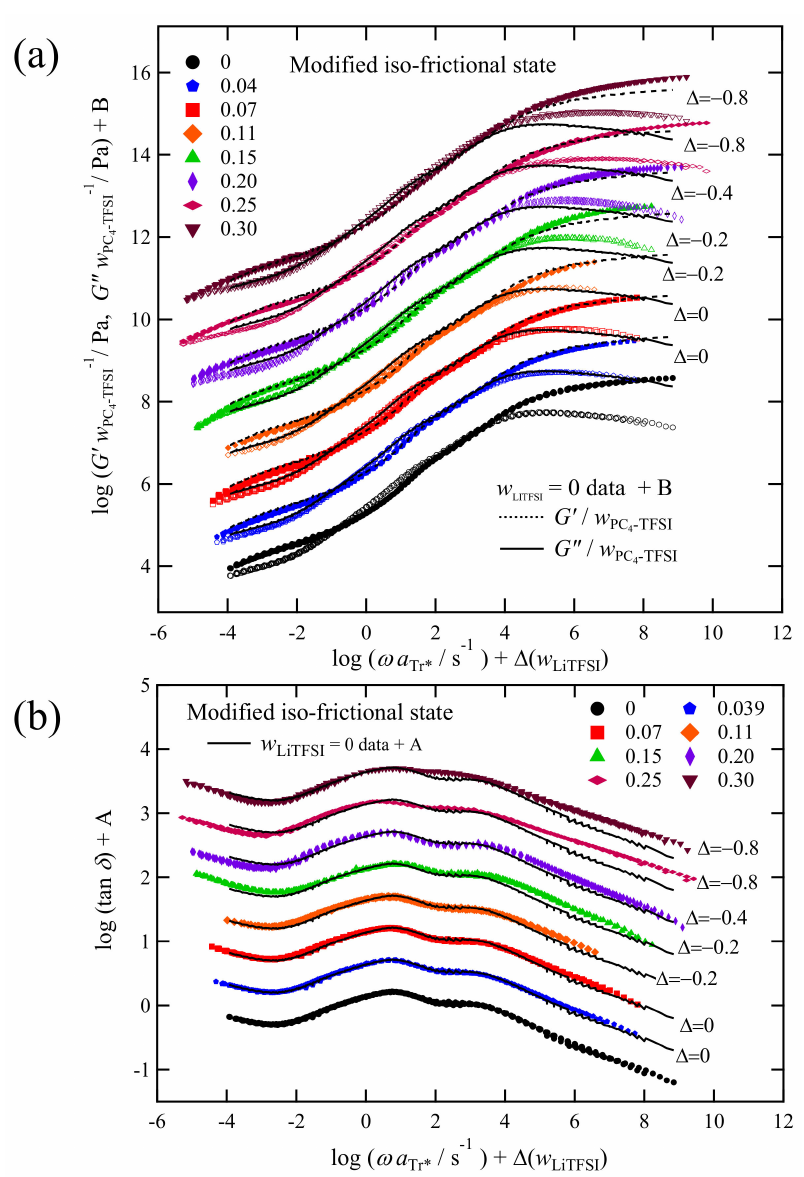
Figure 11. Comparison of ( a ) G ∗ /w PC and ( b ) tan δ in the modified iso-frictional state for 4 − TFSI PC 4 -TFSI/LiTFSI mixtures with various LiTFSI concentrations. The A and B values are the same